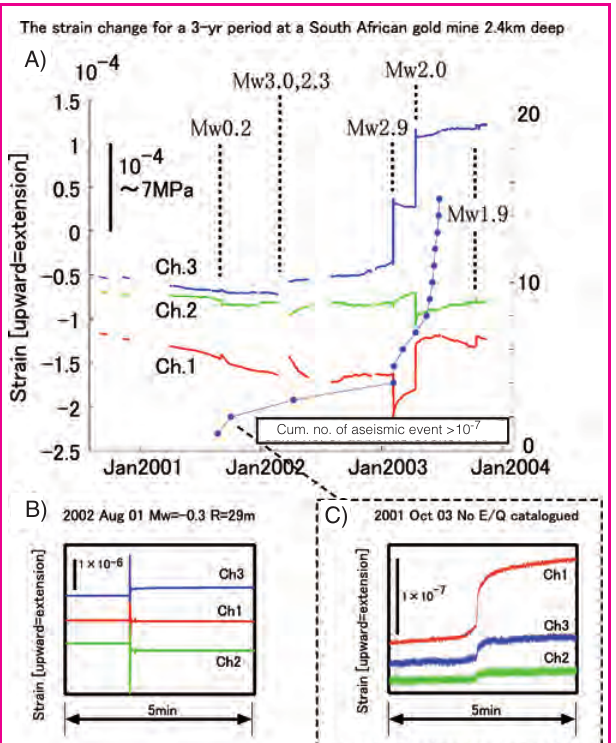
AE Figure 4. [A] a three-year strain changes (red, green, and blue lines) and